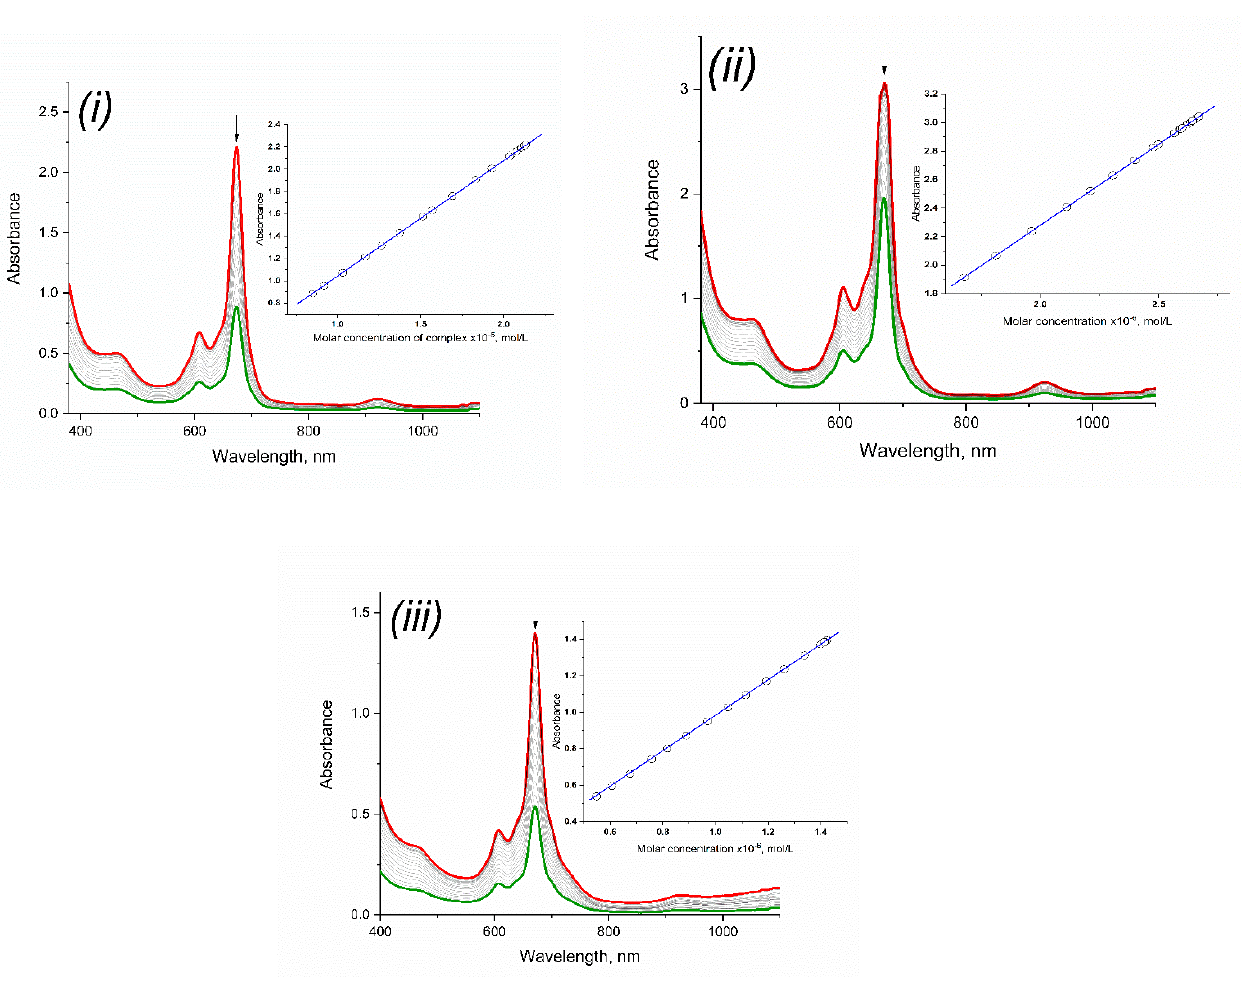
Figure 6. Dilution of solutions of 3 ( i ), 4 ( ii ) and 5 ( iii ) in CHCl 3 at concentration range 2.04 × 10 − 5 ÷ 8.51 × 10 − 6 mol/L. Insertion: Lambert-Bouguer-Beer curves.